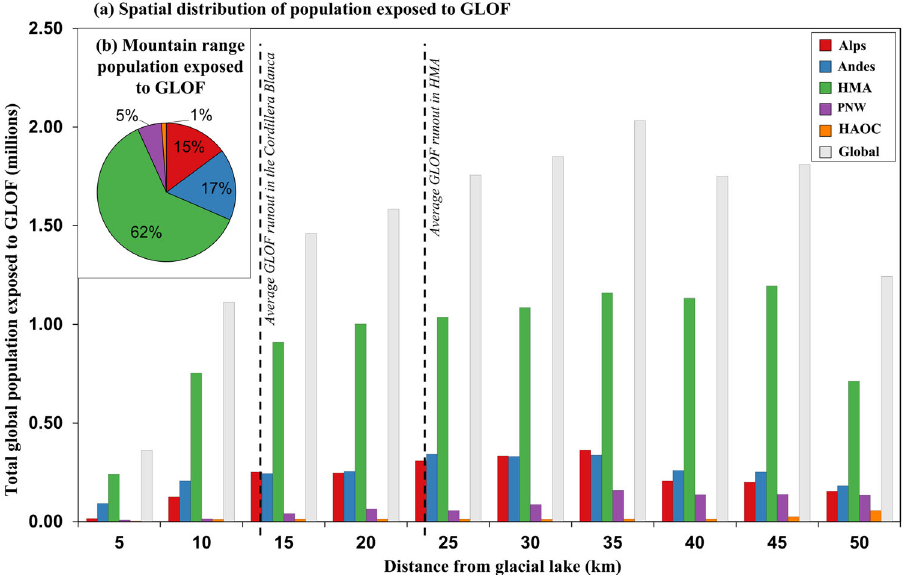
Fig.2|Globalspatialdistributionofexposure.a Spatialdistributionofexposure within GLOF runout tracks up to 50km from a glacial lake, at 5km intervals at the global and mountain range scale. b Total contribution of mountain range to the